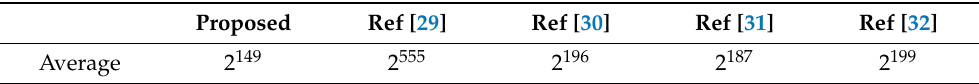
Table 1. Key space Table 1. Key space comparison.